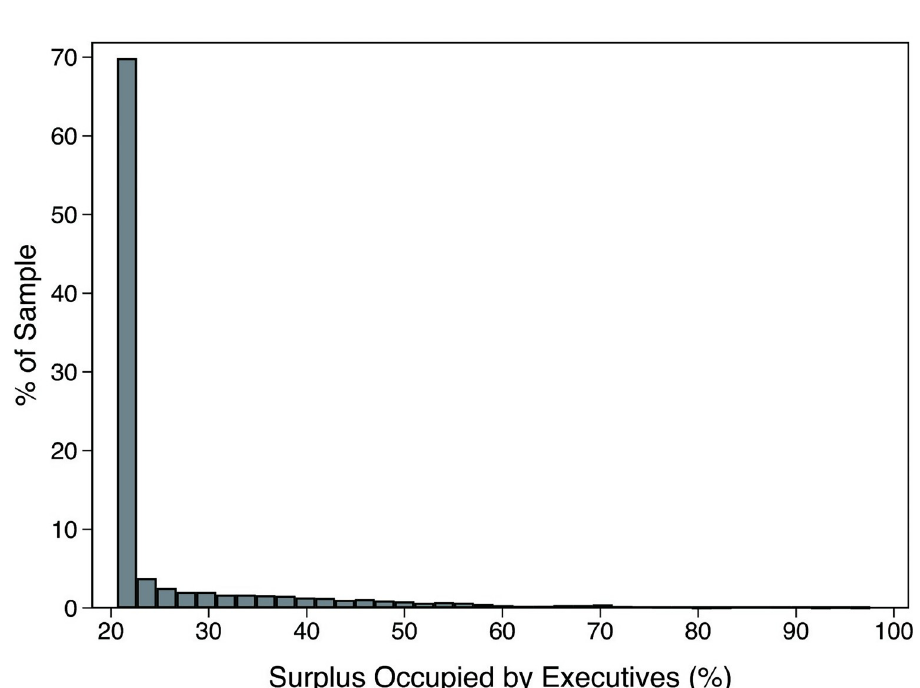
Fig 3. The frequency distribution of the surplus occupied by executives.